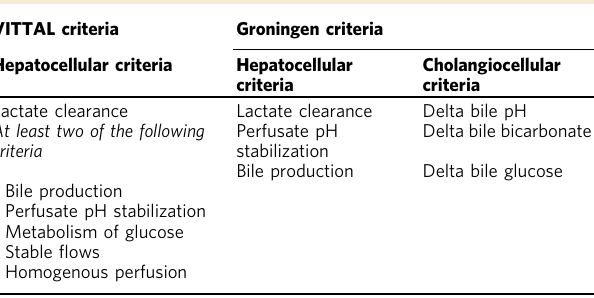
Table 1 Hepatocellular and cholangiocellular viability criteria for human donor livers during NMP a